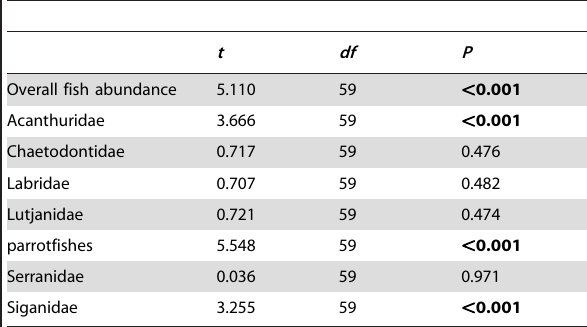
Table 2. Paired t-tests – fixed distance and 5 minute waiting period.